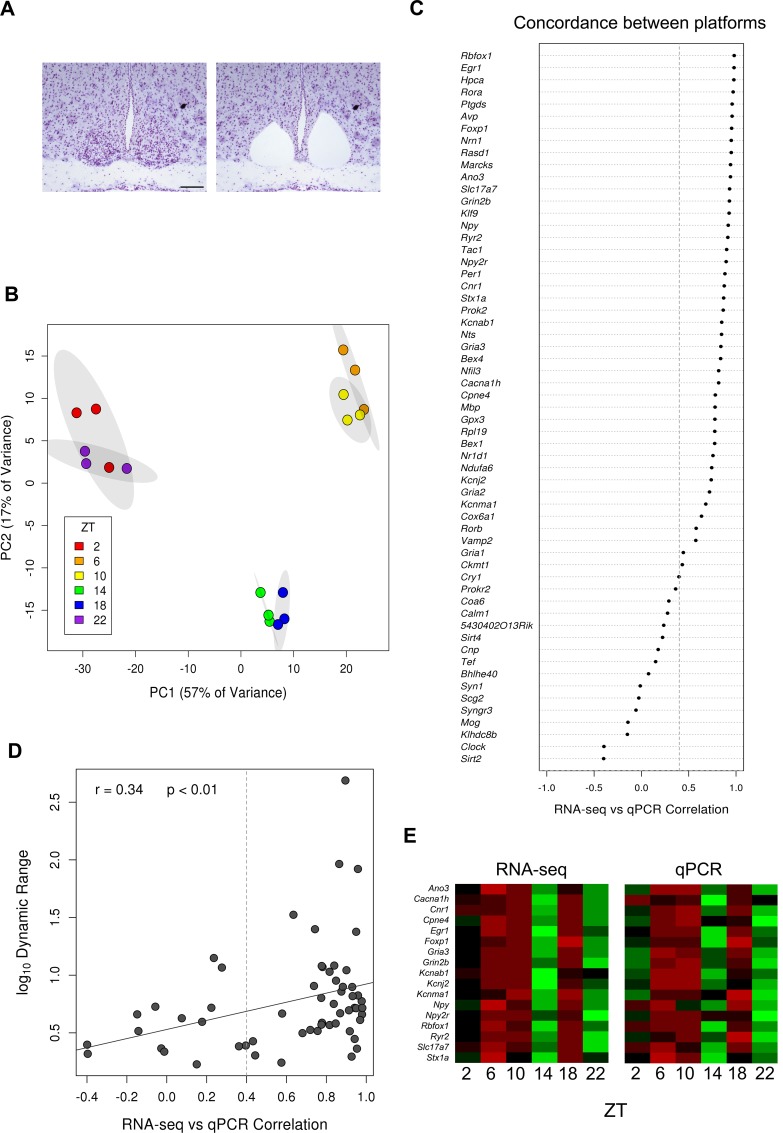
Generation of the SCN transcriptome over 24 hr.(A) Representative Nissl-stained brain sections before and after laser-capture microdissection (LCM) of the SCN. Scale bar: 0.5 mm. (B) Principal component analysis (PCA) plot showing separation of RNA-seq data according to timepoint and sequencing batch. Ellipses delineate the 95% confidence intervals for each timepoint. (C) Dot plot showing the Pearson’s correlation between RNA-seq and quantitative polymerase chain reaction (qPCR) values for all the annotated genes surveyed (excluding those housekeeping genes used to normalise the data); 43/59 genes show a high concordance between methods (r >0.4). (D) Scatter plot showing a trend for increased correlation of cycling gene expression measured in the two different platforms for increased dynamic range. Gene expression values with larger dynamic ranges tend to be less susceptible to extrinsic factors such as random noise and batch effects which therefore contribute less. (E) Heatmap showing the mean expression levels for 17 twin-peaking genes across circadian time according to (i) RNA-seq or (ii) qPCR from LCM SCN samples.